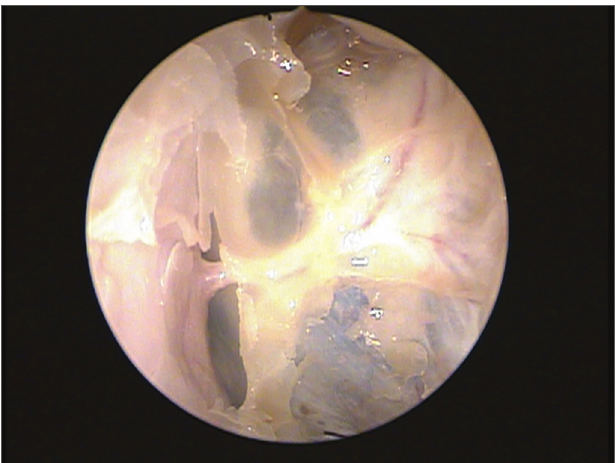
Figura 5. Artéria etmoidal anterior direita, dentro do canal ósseo e exposta em órbita, após retirada de lamina papircea. Observa-se a proximidade com a base do